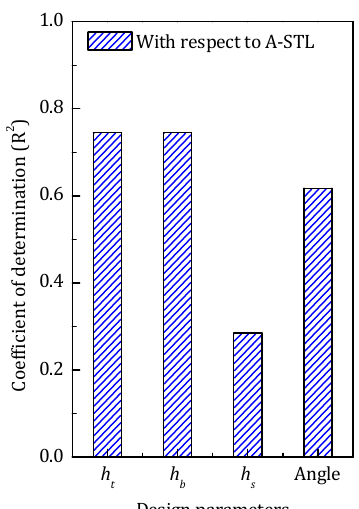
Figure 28. The COD of each design parameter in the high-frequency range.